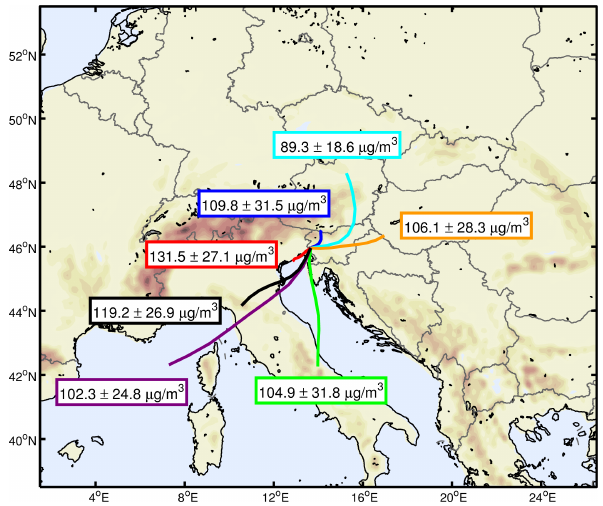
Figure 2. Example of ozone analysis for the Nova Gorica (NG) monitoring site (average daily maximum ± standard deviation) for seven clusters of similar trajectories, as used in the statistical ozone daily maximum forecast for the NG